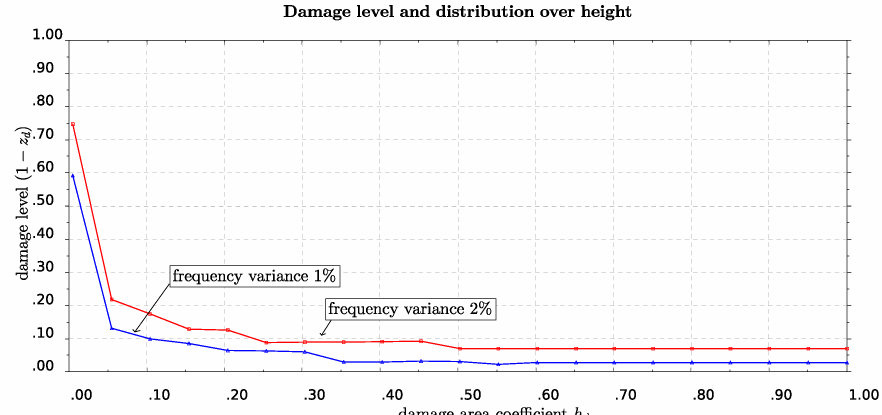
Figure 11. Combination of damage level z with damaged area length h d L , for variation of eigenfreqency ∆ ν = 1% and